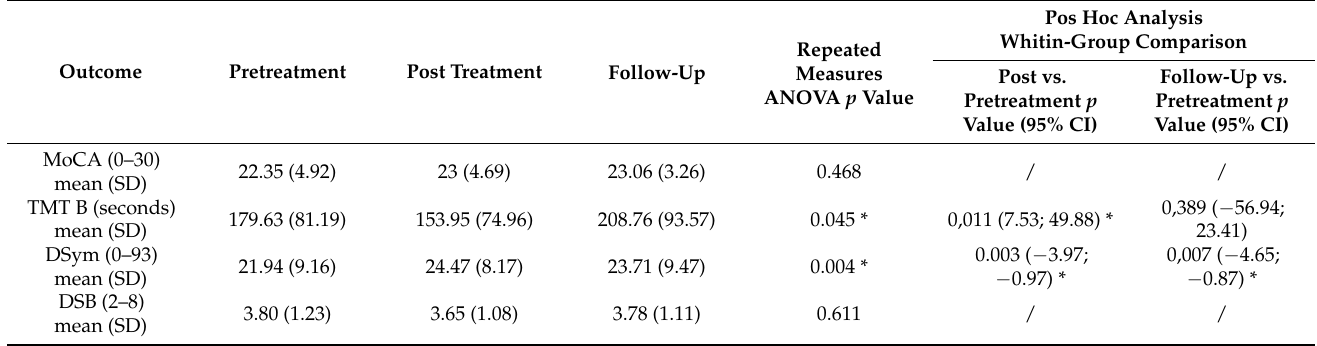
Table 2. Within-group comparisons for outcome measures analyzed using parametric